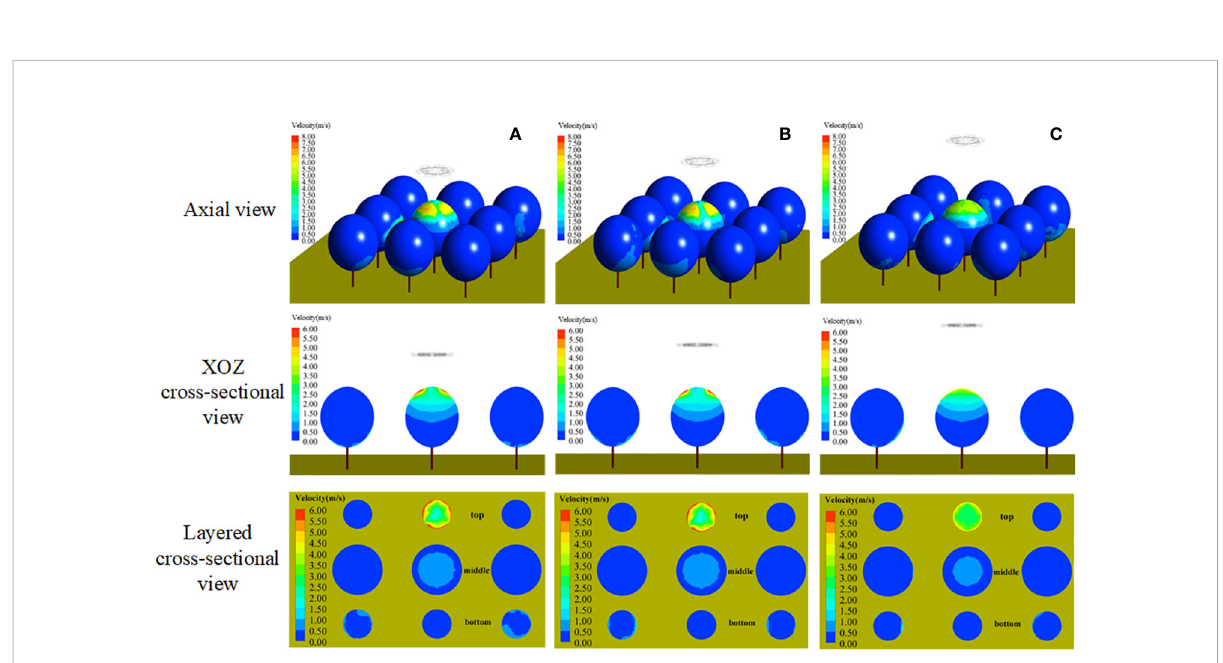
FIGURE 11 Air speed distribution of plant-protection UAV at different heights. (A) Operating height 1.5m. (B) Operating height 2.0m. (C) Operating height 3.0m.